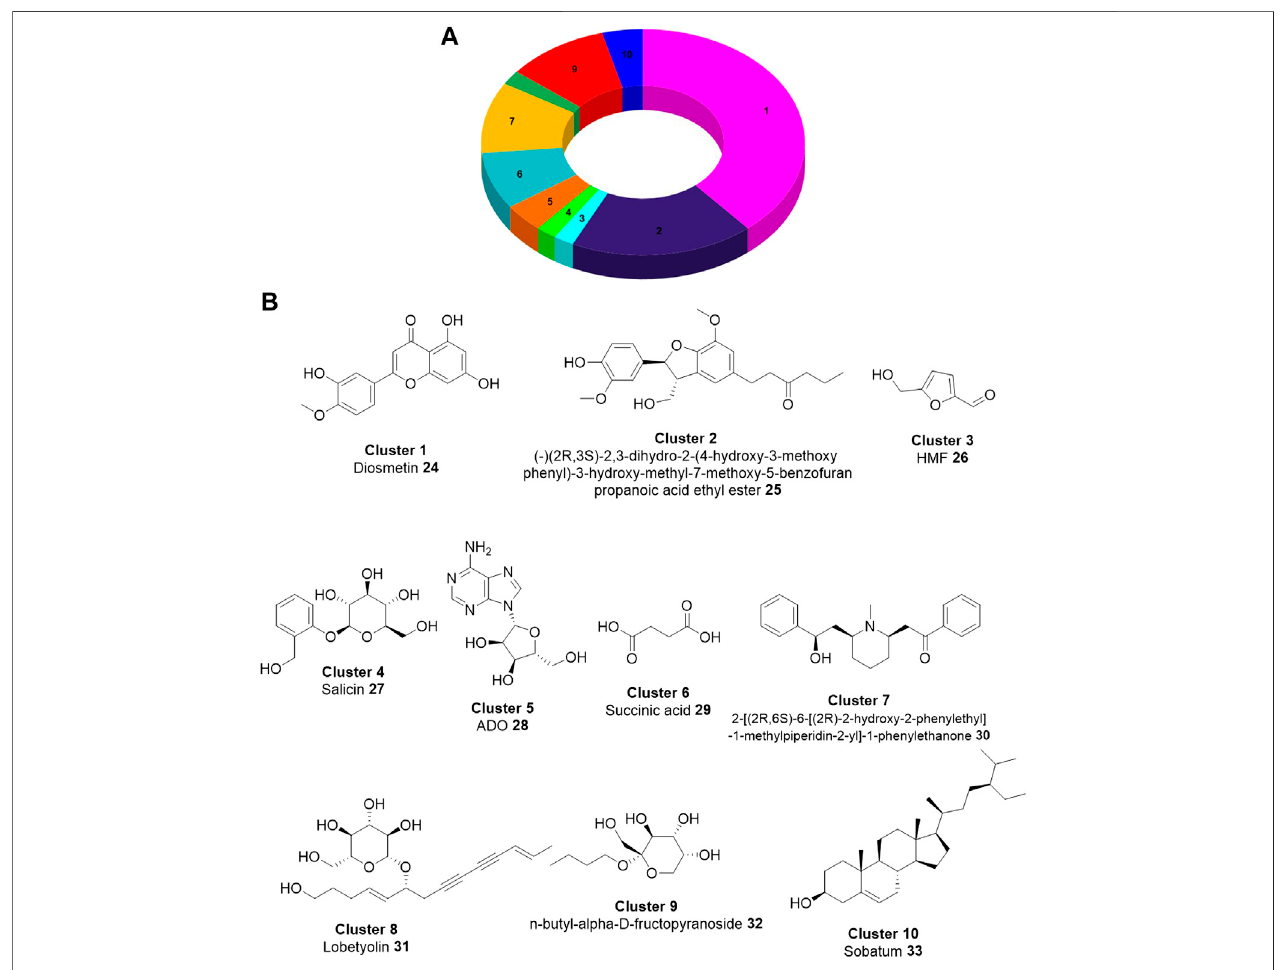
FIGURE4| Chemicaldiversityofthecomponentsderivedfrom17 Lobelia species. (A) .Thedistributionofthechemicalcompoundsinthetop10clustersbasedon ECFP4 fi ngerprint. (B) . Chemical structure of the representative compound in individual clusters (Zheng et al., 2020).